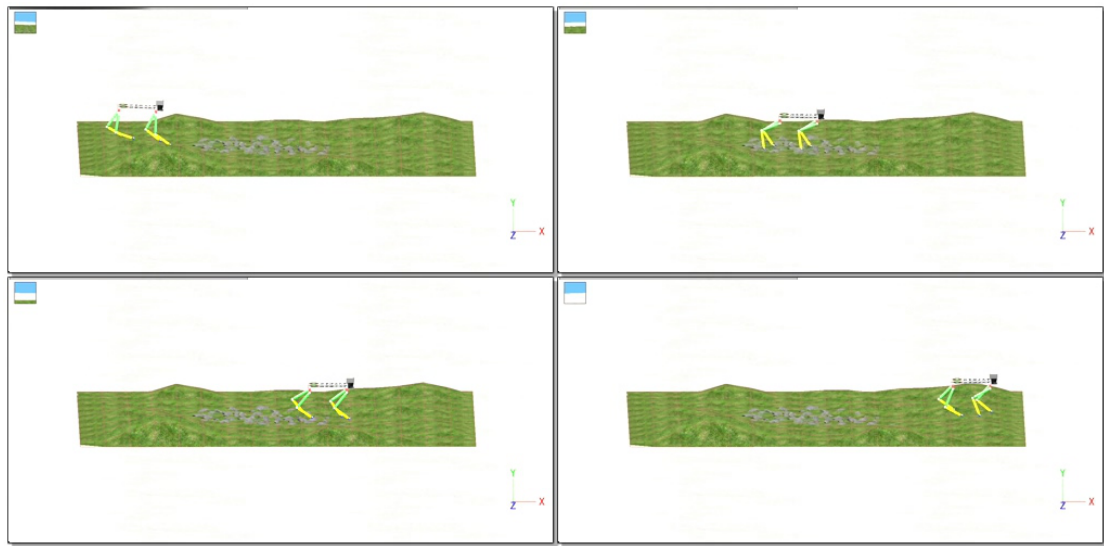
Figure 18. Simulation of the quadruped robot walking on uneven terrain.